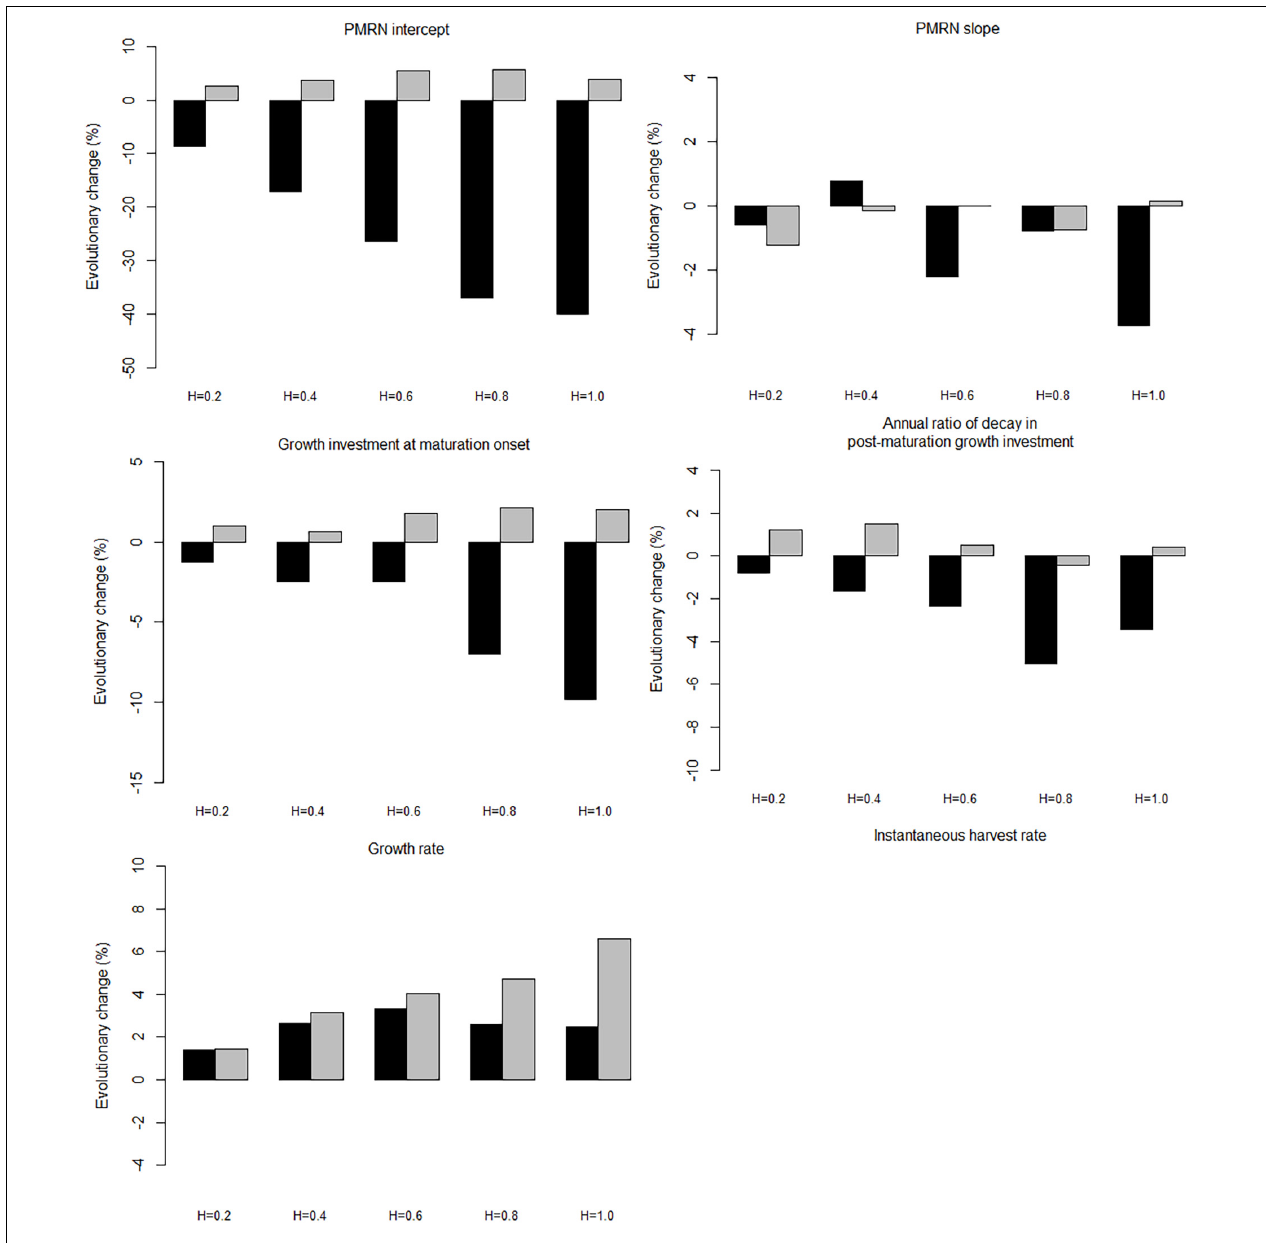
FIGURE 8 | Effect of the maximum instantaneous harvest rate on the mean genotypic value of evolving traits. Panels show the percentage change after 100 years of harvesting, relative to the 100 years before harvesting started. The black bars, trawl-harvested scenarios; the gray bars, gillnet-harvested